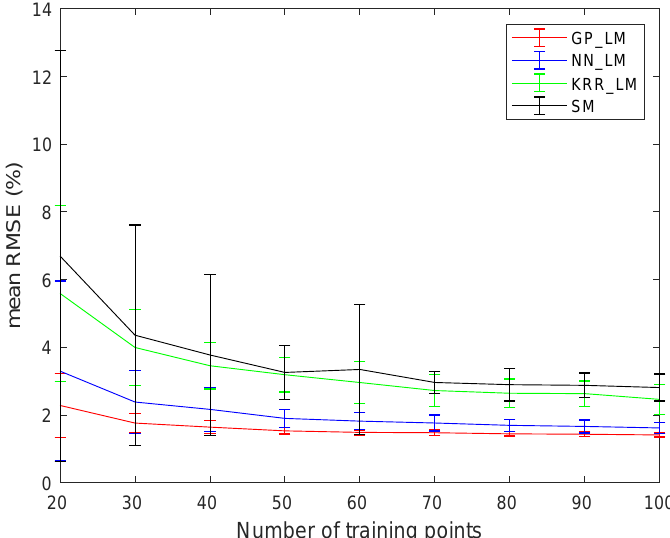
Figure 8. RMSE (100 runs) obtained by the four studied supervised methods as a function of the applied number of training samples in the ray tracing vegetation